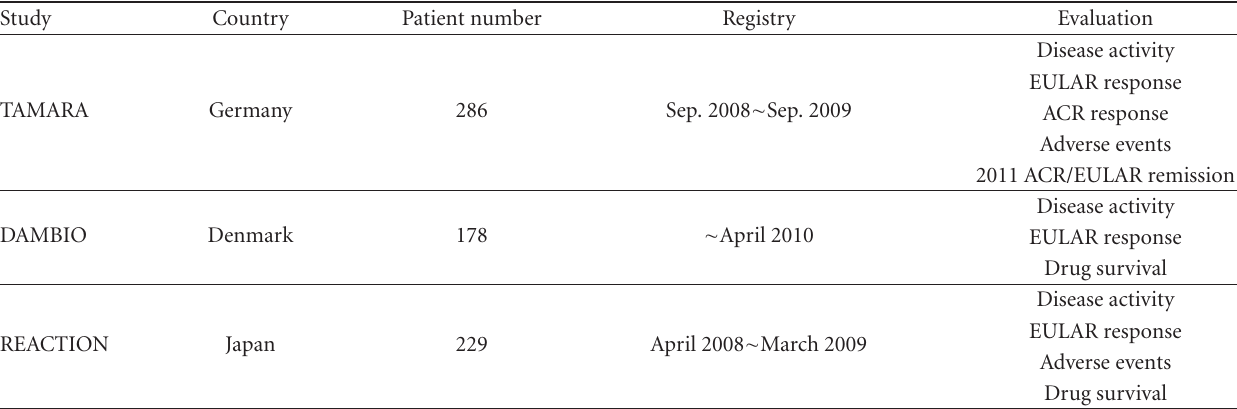
Table 2: Reevaluation of antirheumatic e ff ects of tocilizumab in actual medical practice. Summary of the contents of the three actual medical practice of tocilizumab for rheumatoid